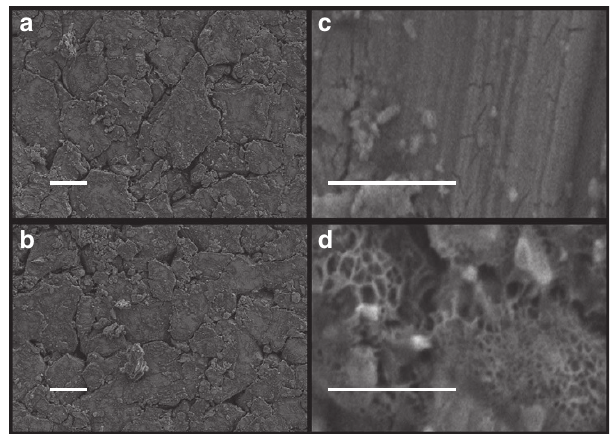
Figure 6 | SEM images. ( a ) Pressed pristine Li(V 0.5 Ti 0.5 )S 2 electrode and ( b ) Li(V 0.5 Ti 0.5 )S 2 electrode after 5 cycles. ( c ) Pristine Li(V 0.5 Ti 0.5 )S 2 electrode and ( d ) Li(V 0.5 Ti 0.5 )S 2 electrode after 1st discharge (intercalation) showing SEI layer formation on the surface of the electrode. Scale bar, ( a , b ) 10 m m, ( c , d ) 1 m